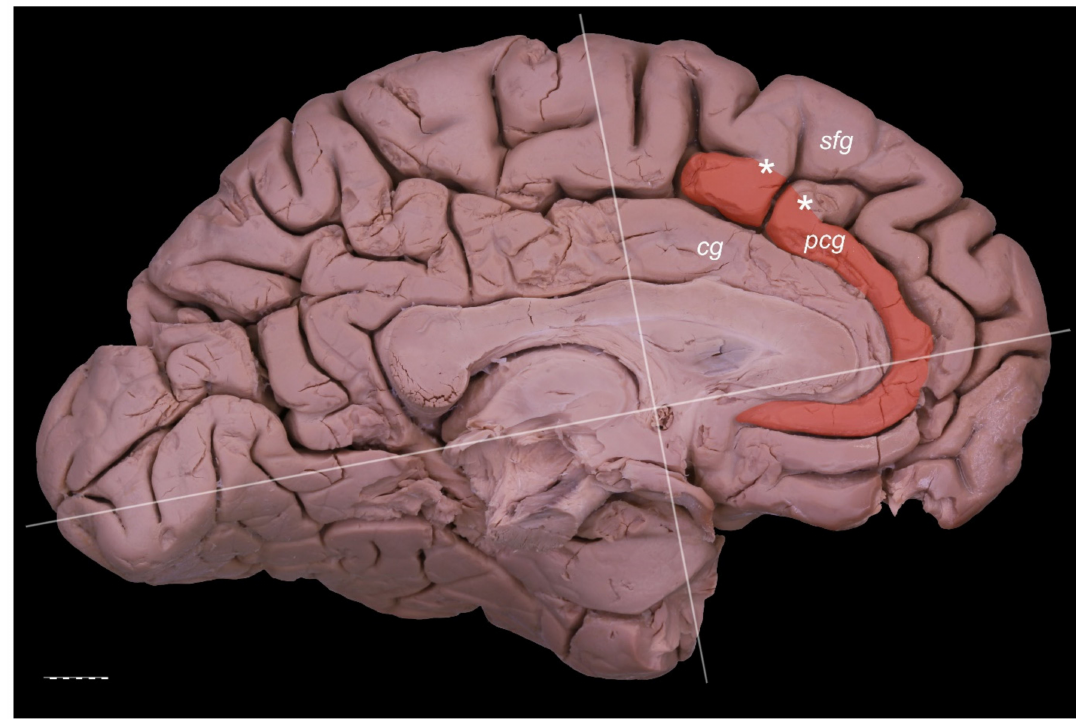
Figure 2. Presence of the PCG. Medial view of the left cerebral hemisphere. cg—cingulate gyrus; pcg—paracingulate gyrus; sfg—superior frontal gyrus. The posterior cingulate gyrus does not reach the level of the VAC line. Interruptions of the PCS (marked by white asterisks) are less than 20 mm. Scale bar corresponds to 10